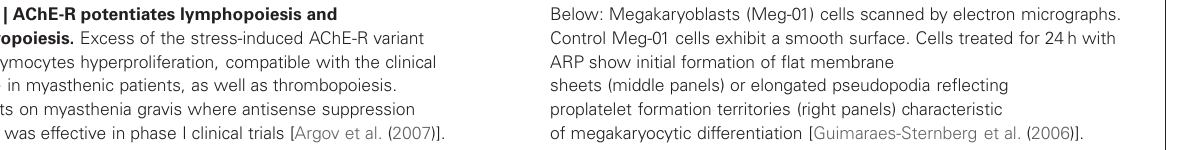
FIGURE 5 | AChE-R potentiates lymphopoiesis and megakaryopoiesis. Excess of the stress-induced AChE-R variant induces thymocytes hyperproliferation, compatible with the clinical phenotype in myasthenic patients, as well as thrombopoiesis. This reflects on myasthenia gravis where antisense suppression of AChE-R was effective in phase I clinical trials [Argov et al. (2007)].